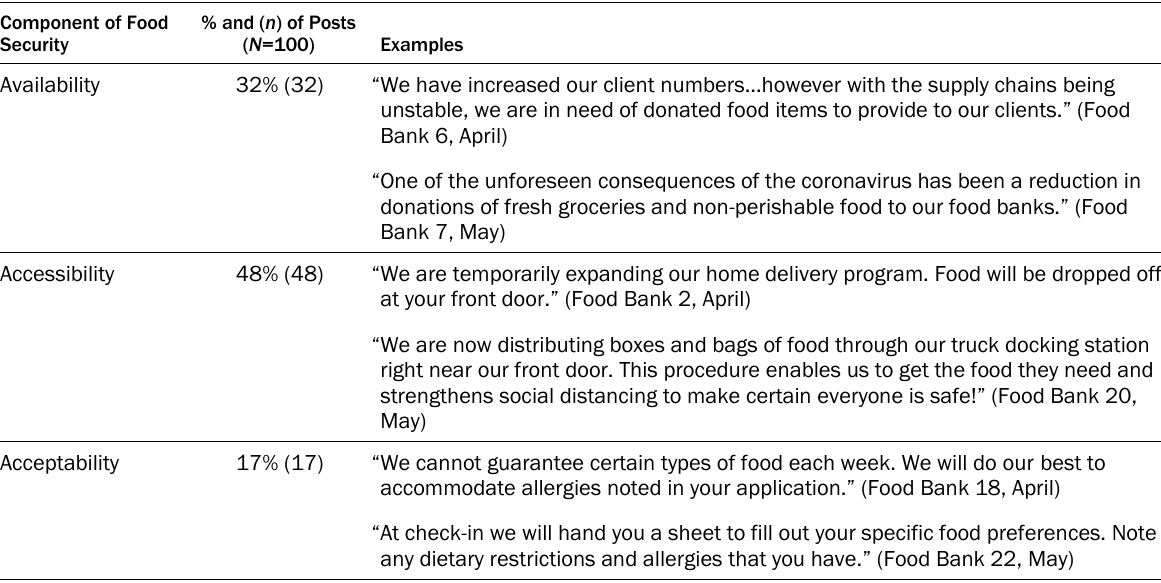
Table 5. Proportion of Seattle Food Bank Website Posts that Communicated Themes Related to Food Availability, Accessibility, and Acceptability in April and May, 2020